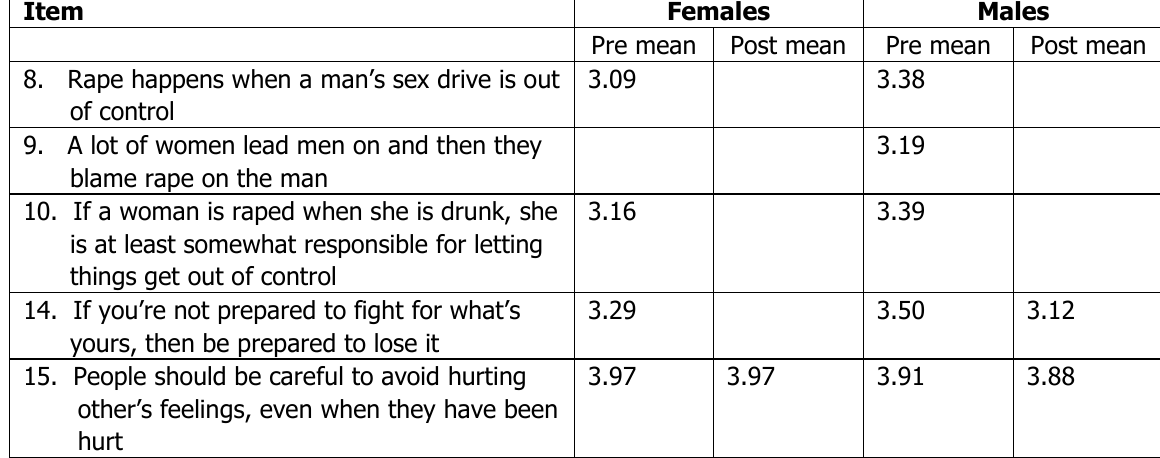
Item Means Greater than 3.00 by